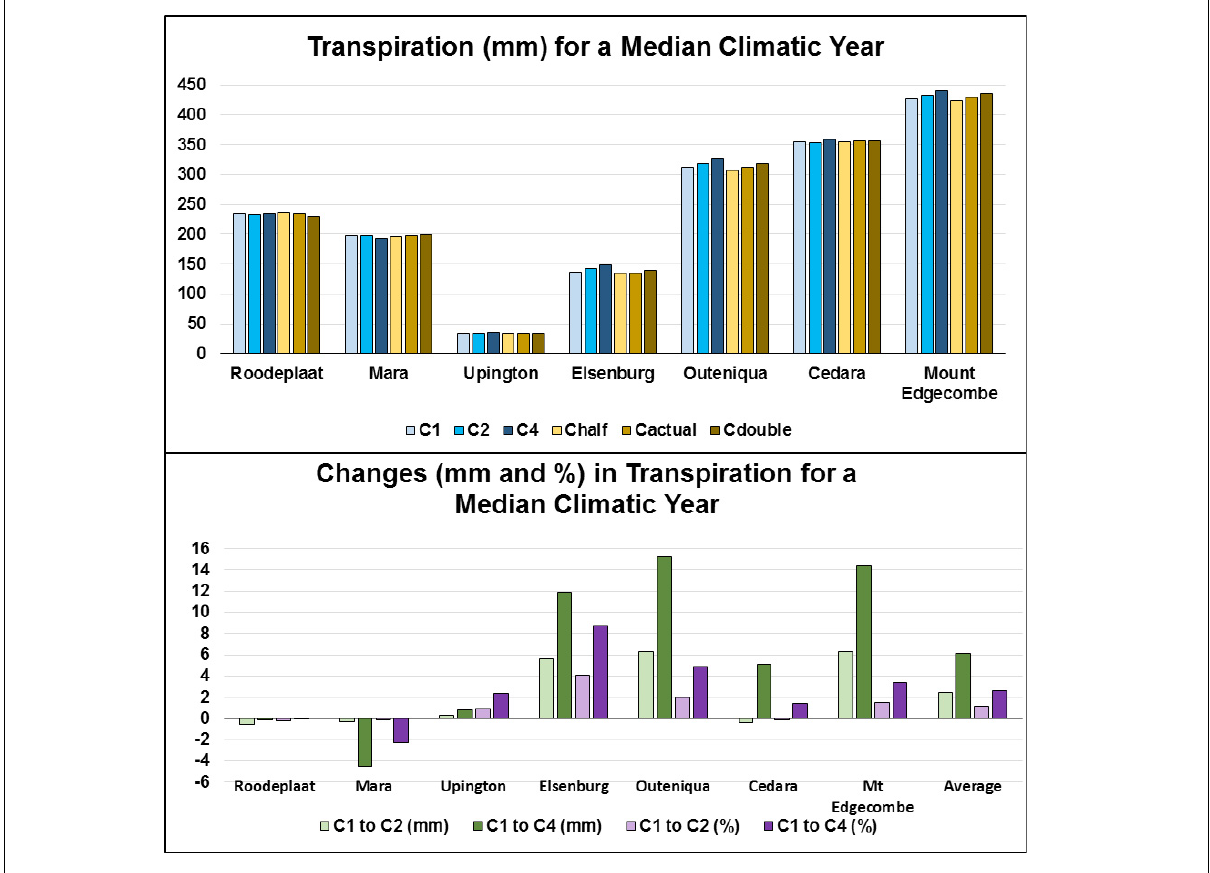
Figure 5: Accumulated transpiration (mm, top) for various soil carbon scenarios at selected locations in South Africa, as well as changes in transpiration from the C to C and from the C to C scenario (% and mm, bottom graph), for a median climatic 1 2 1 4